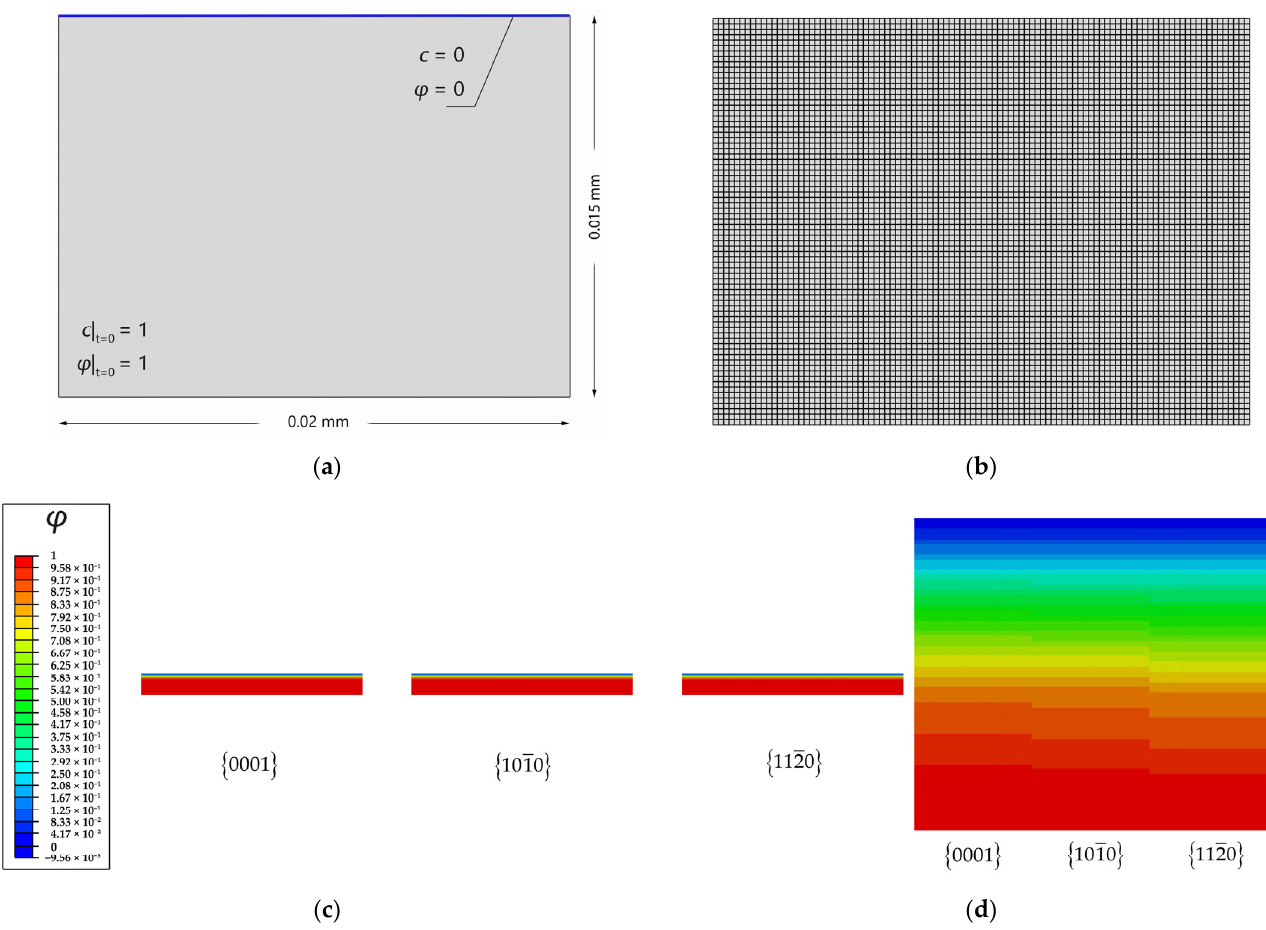
Figure 2. Diffusion-controlled corrosion of three crystallographic planes: ( a ) Schematic of initial and boundary conditions for the Mg crystal with a smooth crystallographic surface exposed in the electrolyte (pure water); ( b ) finite element mesh; ( c ) corrosion of three crystallographic planes after 0.5 T s; ( d ) different corrosion depth among three crystallographic planes after 0.5 T s. The corrosion of the rectangular crystal with three different crystalline surfaces {0001}, (cid:8) (cid:9) (cid:8) (cid:9) 1010 , and 1120 (surface energy densities are listed in Table 2) is simulated. Figure 2c presents the corrosion of different crystal faces at t = 0.5 T s. The red and blue colors cor- respond to the intact and completely dissolved areas, respectively. The crystallographic (cid:8) (cid:9) plane 1120 shows the greatest corrosion depth and mass loss. The